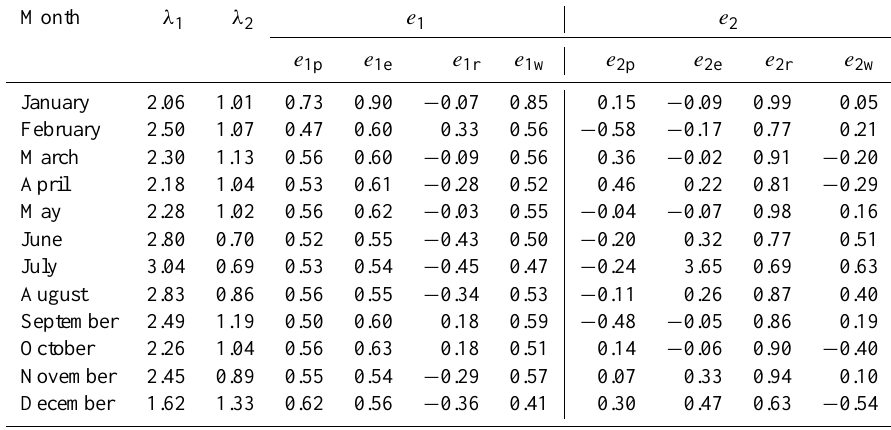
Table 1. Eigenvalues and eigenvectors used for the computation of monthly MDI values. Month λ 1 λ